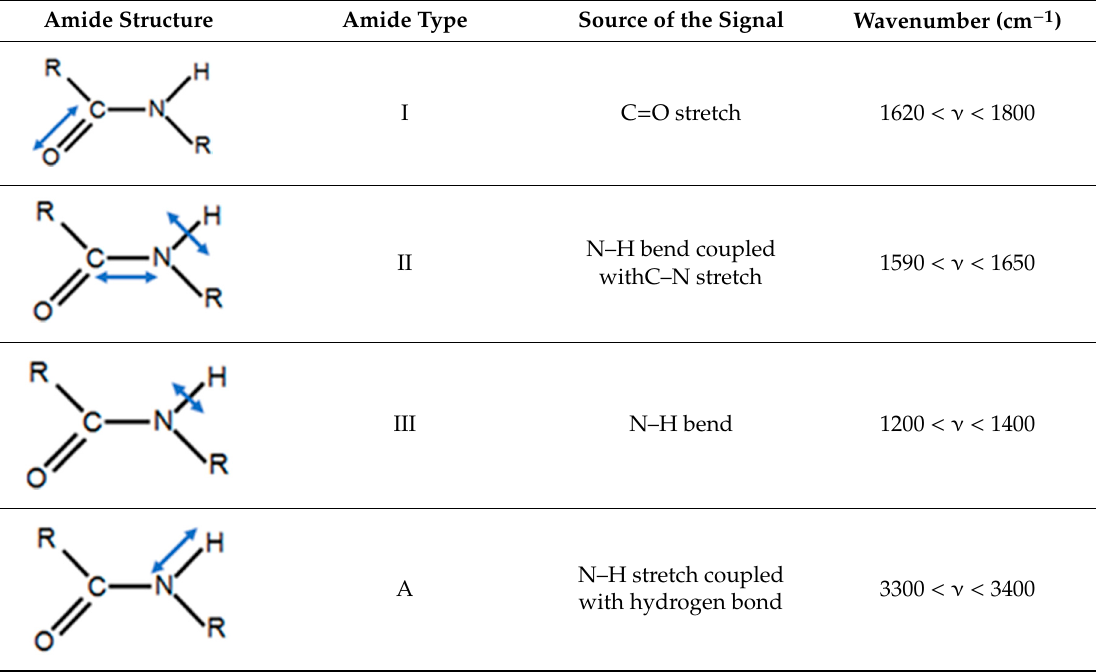
Table 5. Expected molar mass ranges for the peptides of collagen type I. The data for this table has been obtained from [35]